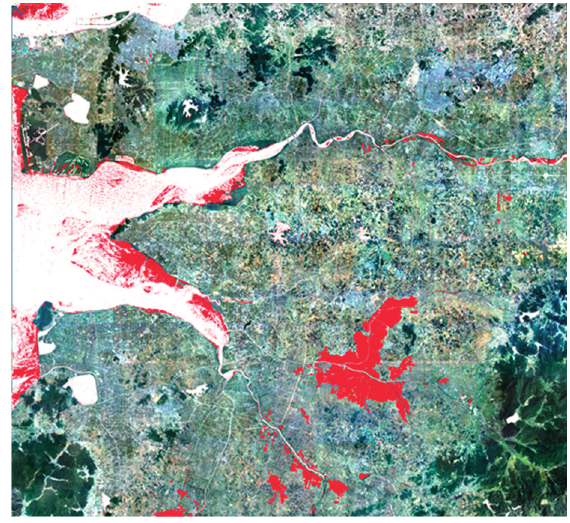
Figure 10. Map of flood area (red: flooded areas, white: permanent water